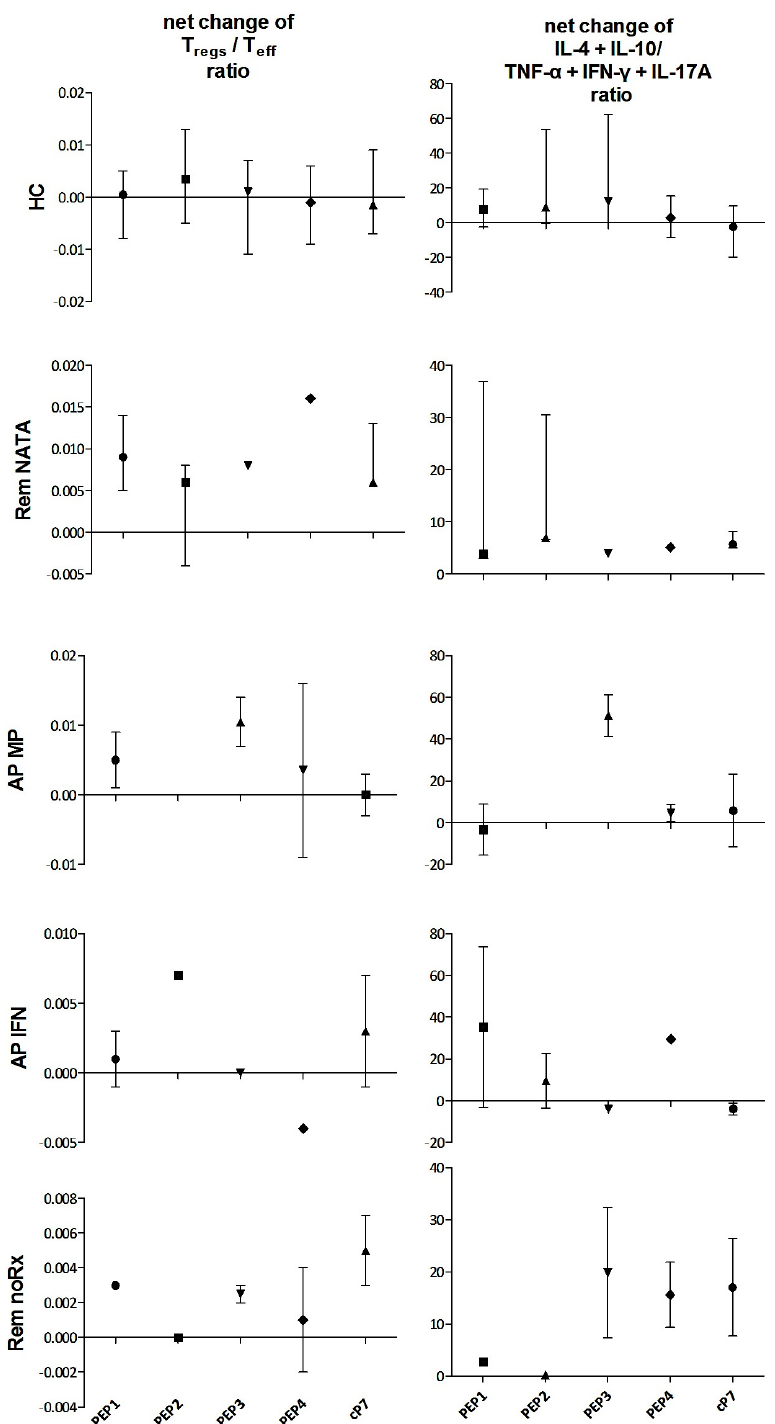
Figure 5. Left column: Net % changes of regulatory/effector ratios (CD4 + CD25 + /CD4 + CD25 − ) after 72 h culture of PBMC of MS patients and HC with the antigenic peptides PEP1-4 or cP7; Right column : Net % changes in the corresponding anti-inflammatory/inflammatory cytokine ratios ([IL-4 + IL-10]/[IFN- γ + TNF- α + IL-17A]) in the culture supernatants.